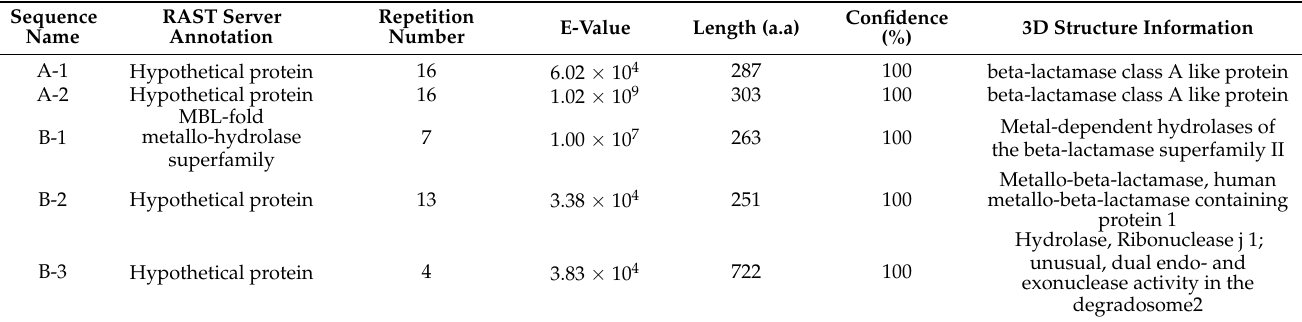
Table 1. Data for the CPR putative class A and class B beta-lactamase sequences tested in